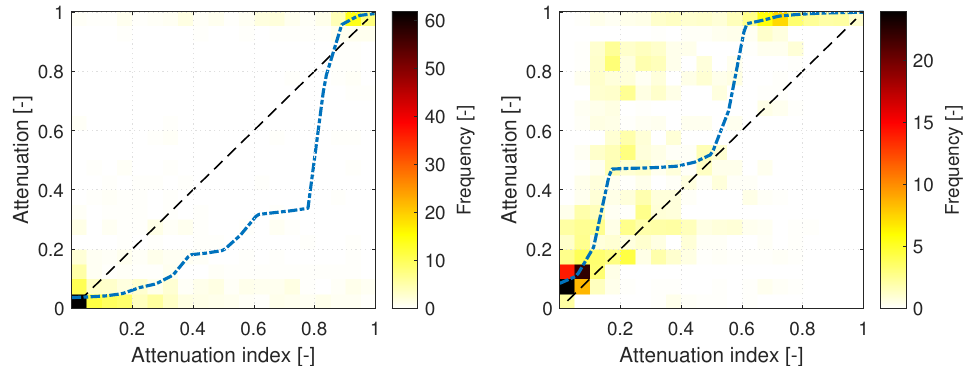
Figure 7. These plots show the weighted observations of attenuation index and attenuation (color coded) and the resulting fitted function ˆ A (blue dash-dotted curve). The left panel